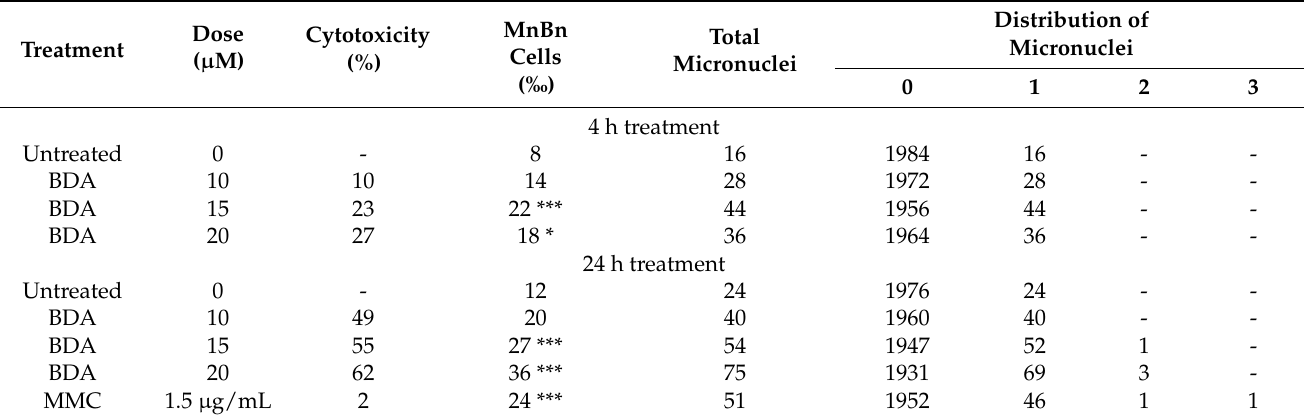
Table 3. Micronuclei induced by BDA in L5178Y